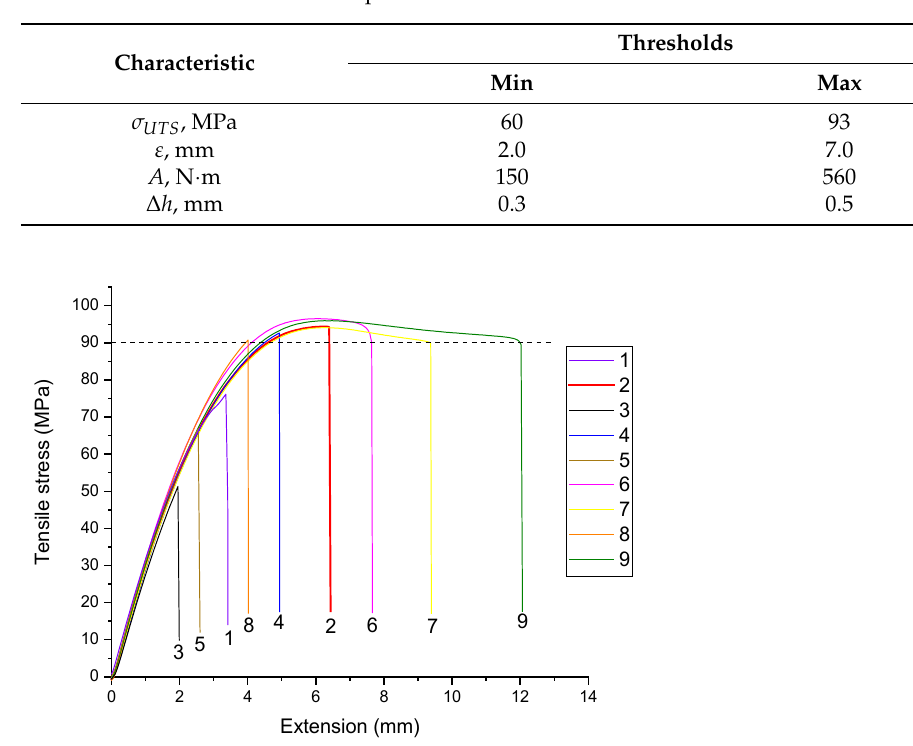
Table 6. Threshold values for the optimal conditions.